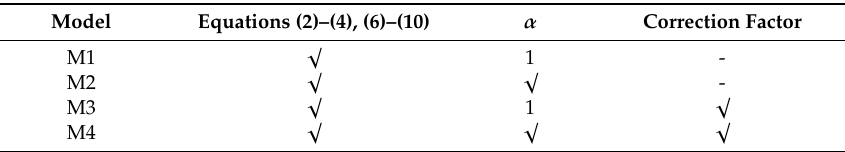
Table 3. The details of the models.